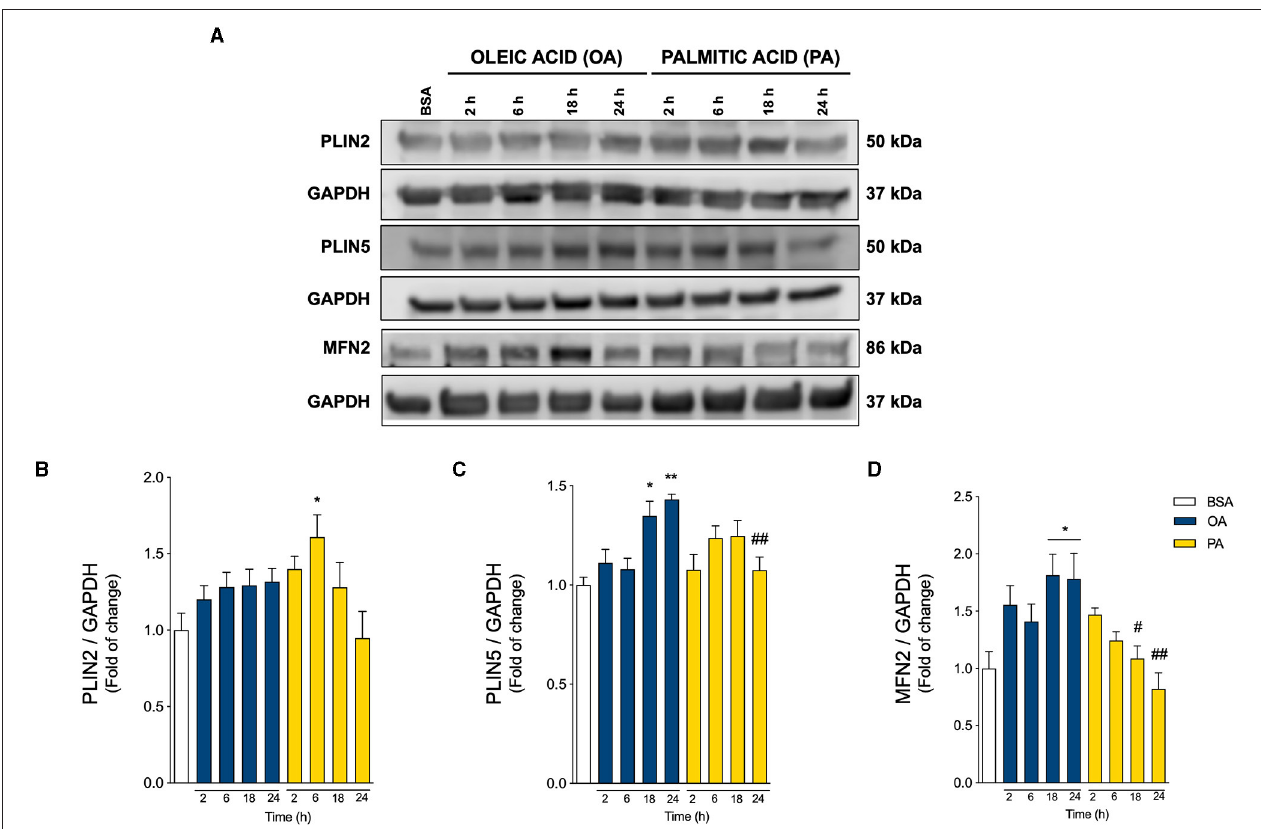
FIGURE 3 | Oleic and palmitic acids induce different patterns of lipid droplet-mitochondria tether proteins in HepG2 cells. (A) Representative Western blots of the proteins associated with lipid droplet (LD)-mitochondria physical interaction: Perilipin 2 and 5 (PLIN2, PLIN5), and Mitofusin 2 (MFN2) in HepG2 cells treated with 200 µ M of oleic acid (OA) or palmitic acid (PA) for 0–24h. GAPDH was used as a loading control. (B–D) Densitometric quantification of the proteins indicated in A . Data are expressed as mean ± SEM of N = 7 for PLIN2 and N = 4 for PLIN5 and MFN2. * p < 0.05; ** p < 0.01 vs. BSA; # p < 0.05; and ## p < 0.01 vs. OA at the same time